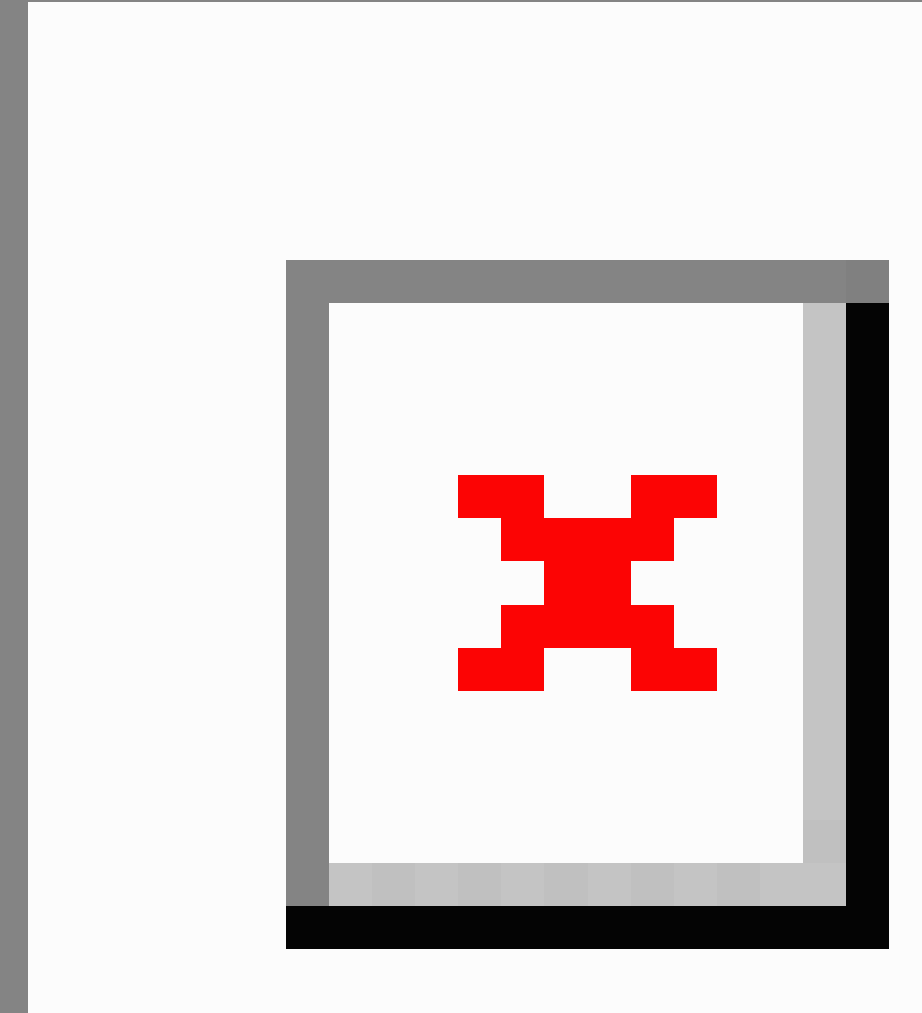
Figure 13. Population trend